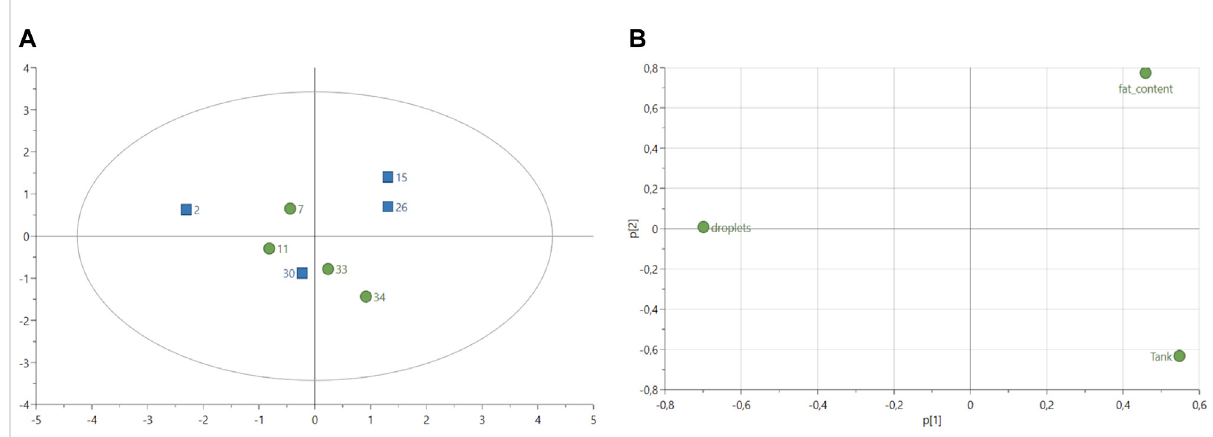
FIGURE 3 (A) Score plot of principal component analysis (PCA) model of lipid droplets calculated from histological data ( n = 8 in total, four samples per treatment). Variable fi sh tanks and fat content (%) were included in the analysis. Green circles: fi sh-fed control feed. Blue squares: fi sh fed with experimentalfeed.PCAscoreplot(alldata,with2 PCs)withparameters:R 2 X=50.4%,R 2 X2=32.6%,Q 2 X= − 36.6%. (B) LoadingsplotfromPCAmodel shown in (A)